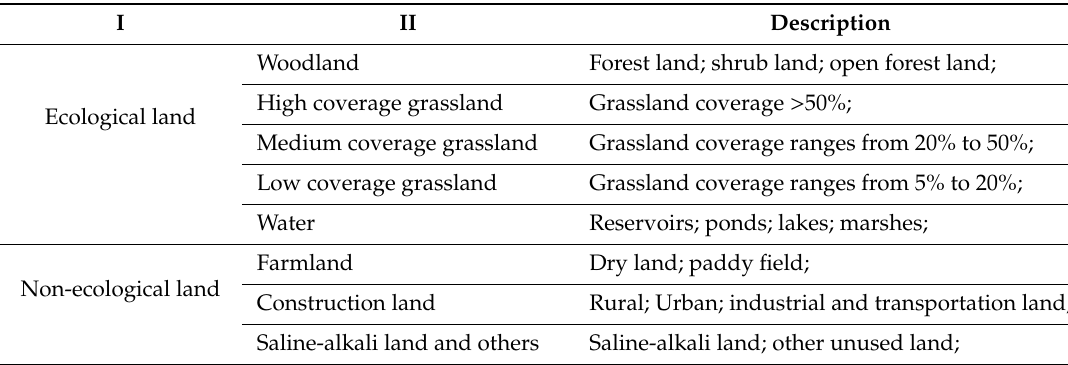
Table 3. Classification system of land use in the study